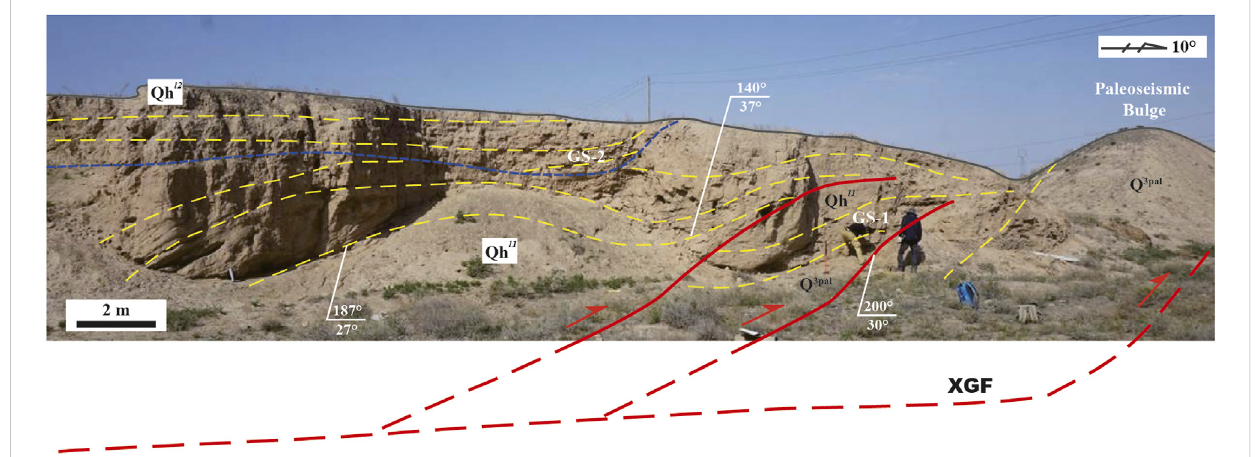
FIGURE 6 ross-sectional view of the Dagengzi Fault (DGF), showing imbricated thrusting along the blind DGF and folding of multi-stage growth strata. GS-1 and GS-2, two-stage growth strata. Qp 3apl , alluvial – pluvial deposits of the Upper Pleistocene. Qh l1 and Qh l2 , lower and upper layers of the Holocene lacustrine sediments. See location in Figure